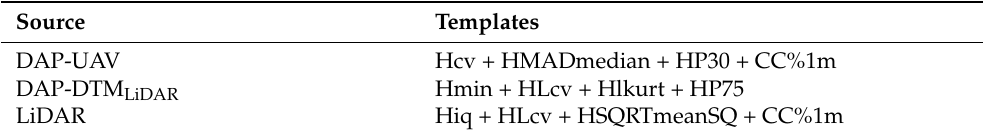
Table 8. Models selected to estimate average height from DAP-UAV, DAP-DTM LiDAR , and